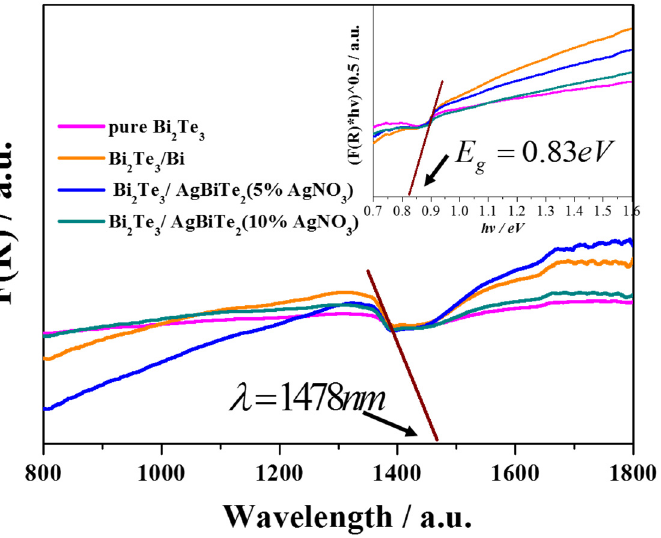
Figure 5. UV–Vis absorption spectra and diffuse-reflectance UV–Vis spectrum (the right upper inset) of Bi 2 Te 3 powders.